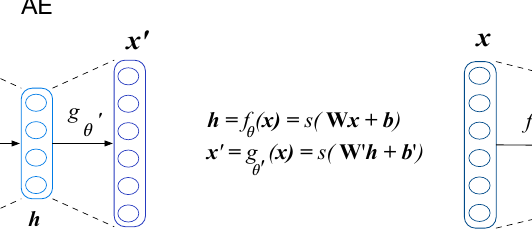
Figure 1. Structure of single- and multi-layer